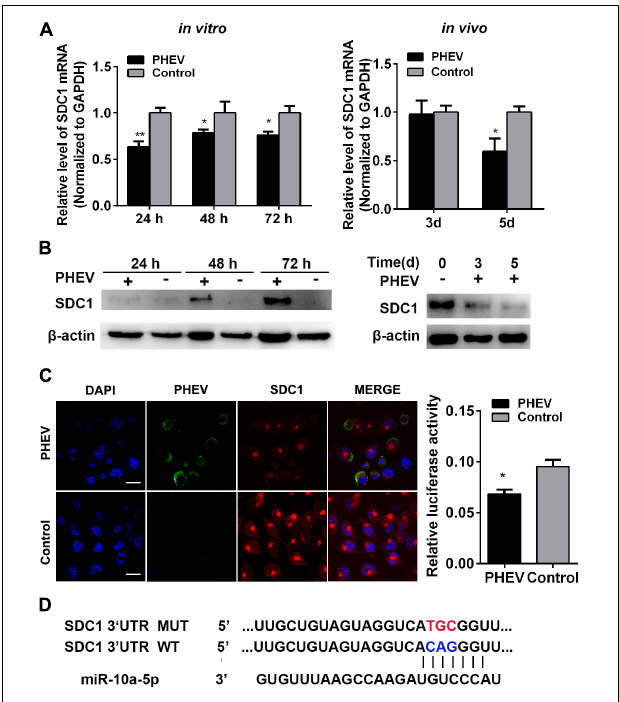
FIGURE 3 | Syndecan 1 (SDC1) expression was inhibited during porcine hemagglutinating encephalomyelitis virus (PHEV) infection. (A) N2a cells were incubated with PHEV for 24 ∼ 72 h in vitro , whereas the BALB/c mice were infected with PHEV for 3 or 5 days in vivo . N = 4 mice per group, three independent experiments. The endogenous SDC1 mRNA expression was determined by qRT-PCR. (B) The lysates from cells or mice that treated as described as (A) were harvested and detected by western blotting using primary antibodies against SDC1 or beta actin. (C) N2a cells were incubated with PHEV for 24 h and then fixed and labeled with antibodies against PHEV (green) and SDC1 (red). The cell nucleus was stained with DAPI (blue). Representative micrograph is shown, and quantitative analyses of the Rab3a staining are listed on the right. Bars indicate 20 µ m. All of the data are representative of at least three independent experiments (* p < 0.05, ** p < 0.01). (D) Sequence alignment of miR-10a-5p in TargetScan website and its target site in 3 (cid:48) UTR of SDC1 mRNA are shown. Model of wild- and mutant-type constructs of SDC1 mRNA 3 (cid:48) UTR. The red letters indicate the point